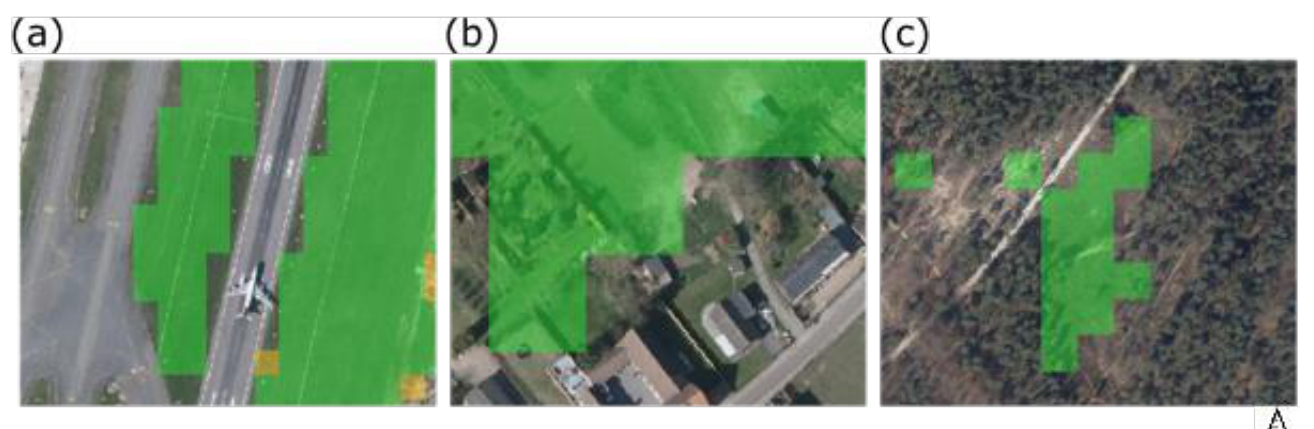
Figure 3. Examples of non-agricultural grassland correctly being classified by the historical land cover classification maps: ( a ) grass strips in airports, ( b ) gardens, ( c ) natural grasslands. Background orthophoto is from April 2021 [28].